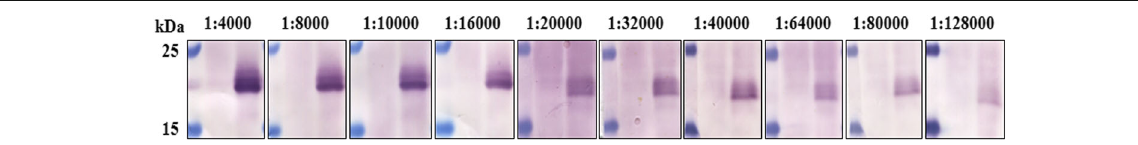
Fig. 2 Titer determination of PLRV-MP antiserum by Western blotting. Antiserum used at 10 different dilutions (1:4000, 1:8000, 1:10000, 1:16000,